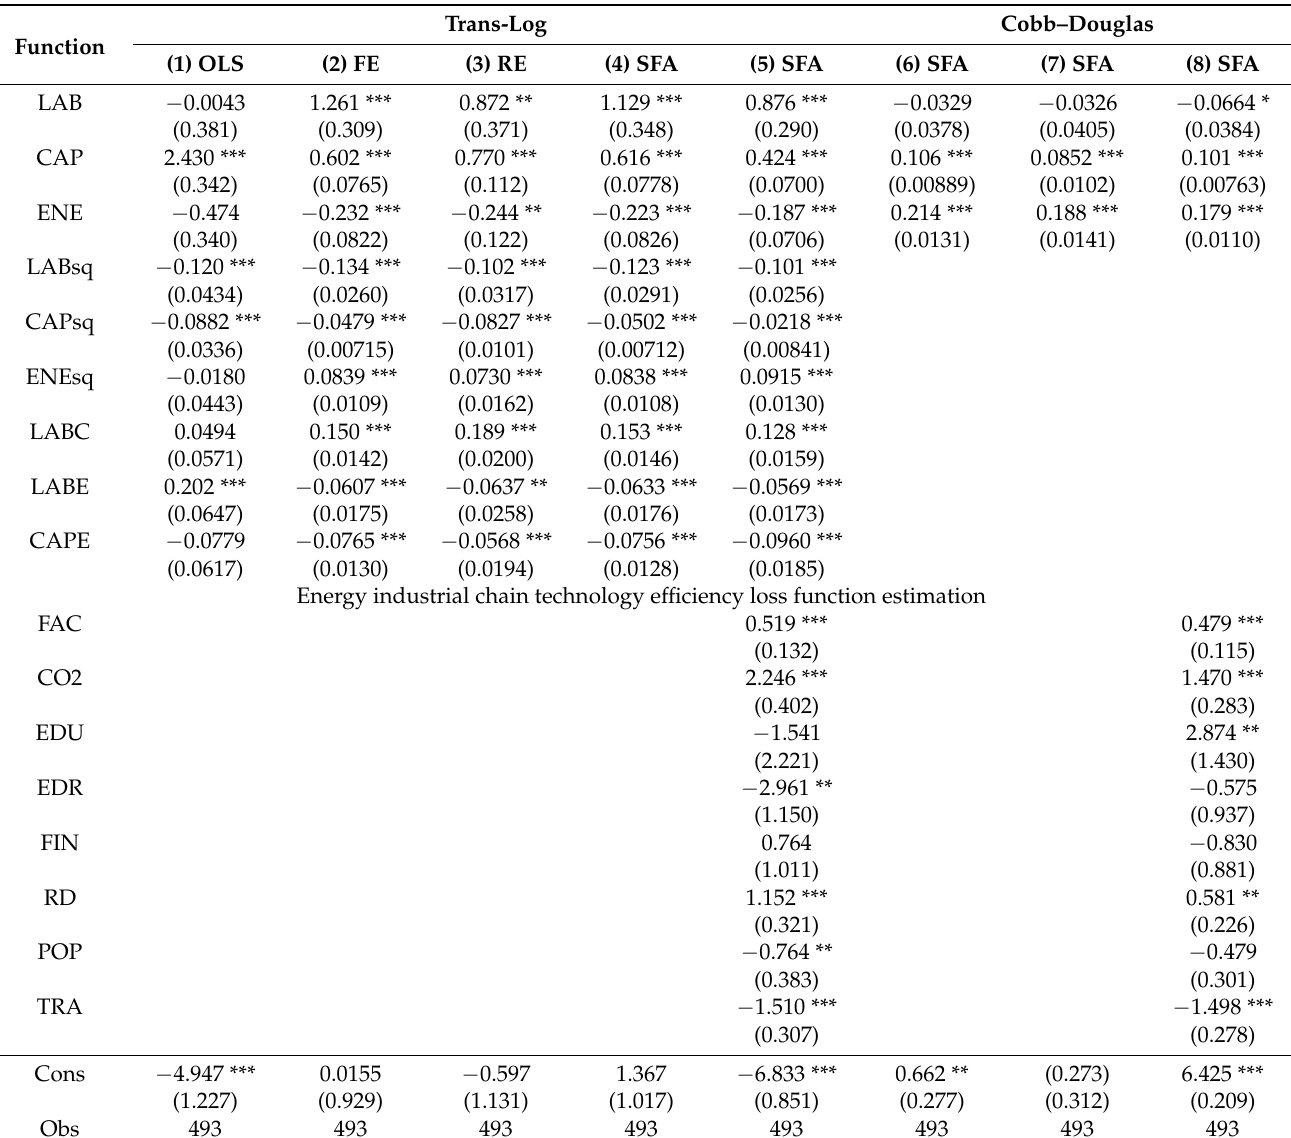
Table 3. Comparison of the effects of factor distortions and carbon dioxide emissions on energy industrial chain technology